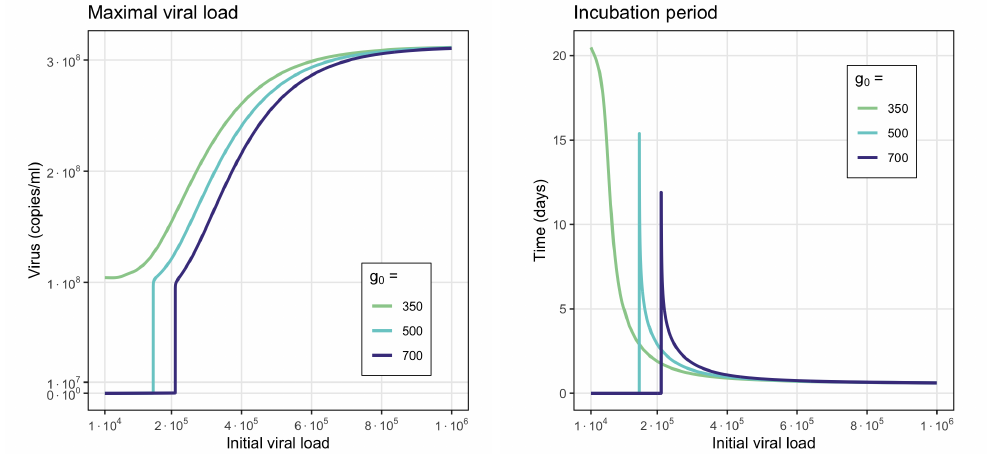
Figure 5. Maximal viral load ( left ) and incubation period ( right ) as functions of the initial viral load in numerical simulations of system (1)–(6). The vertical lines are the viral load values at which the system switched in convergence from the first to the third stationary point. The violet line corresponds to the monostable case with one large stationary